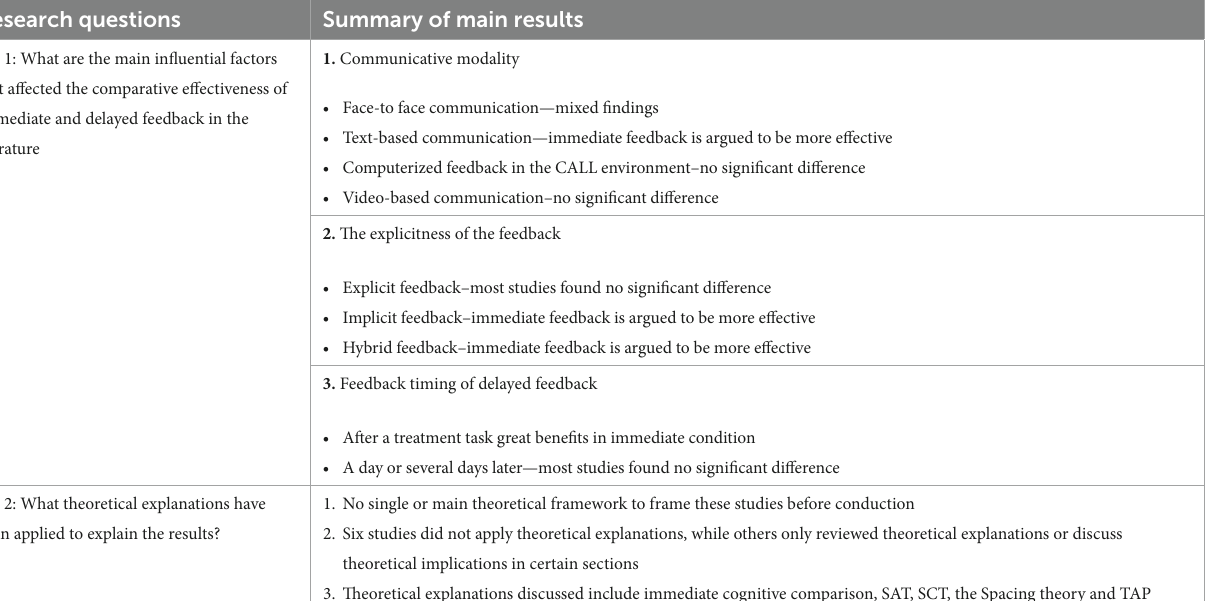
TABLE 2 Summary of the main